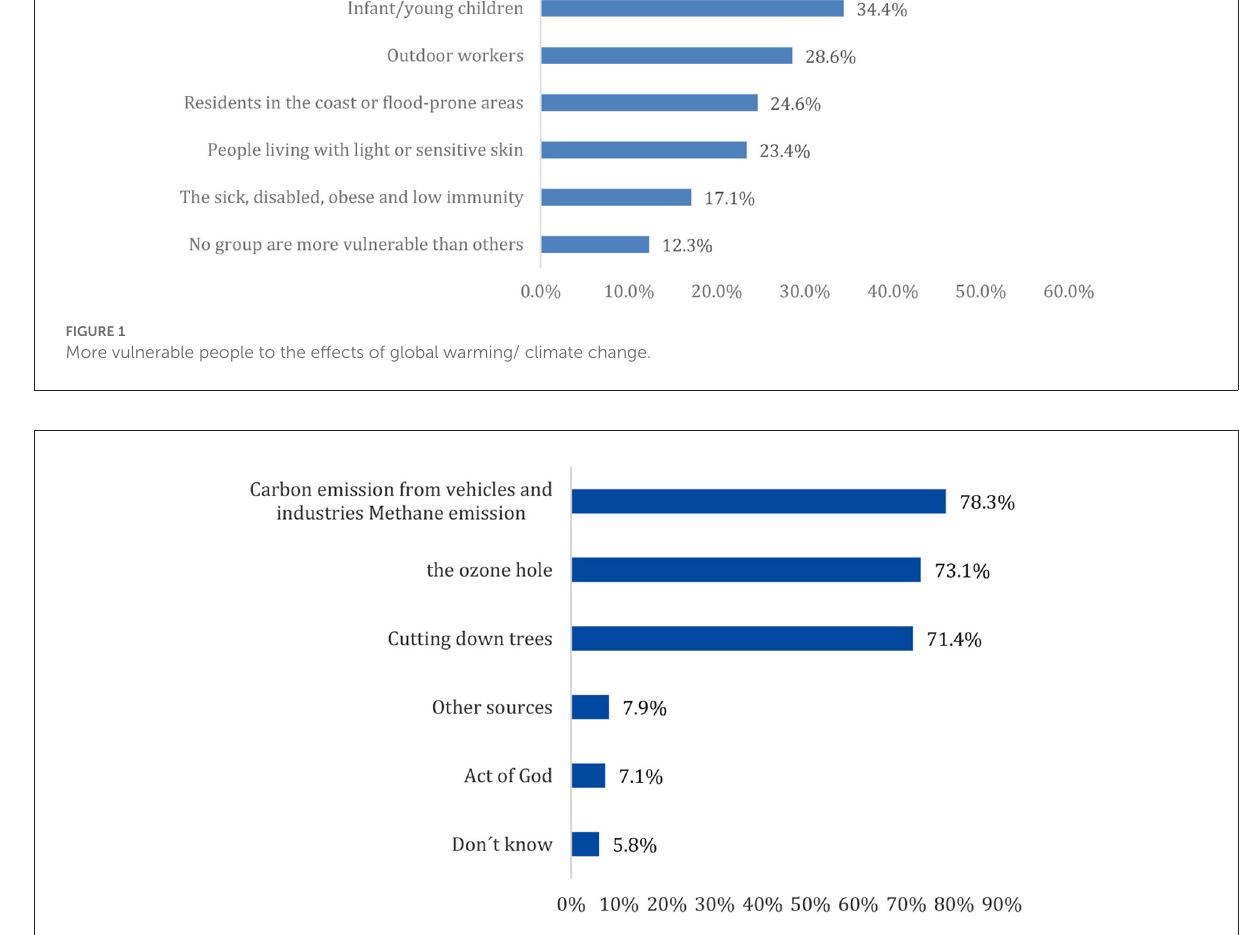
FIGURE2 Factors contribute to climate change as reported by the enrolled